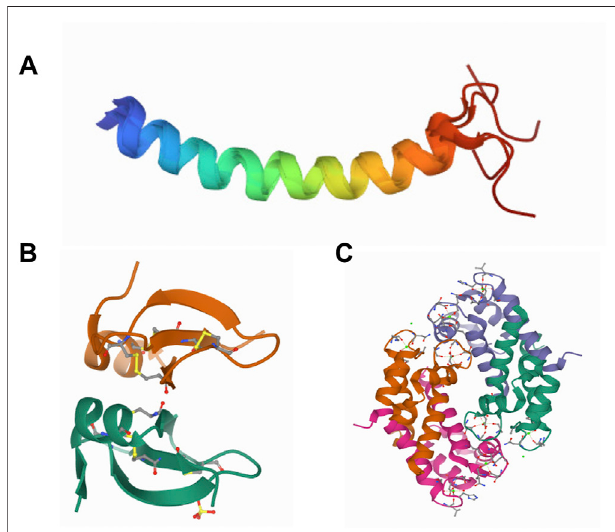
FIGURE 4 | Representative structures of AMPs. Structures of LL-37 (Wang, 2008) (A) , hBD-2 (Hoover et al., 2000) (B) , and crystal structure of human calprotectin (S100A8/S100A9) (Korndorfer et al., 2007) (C)